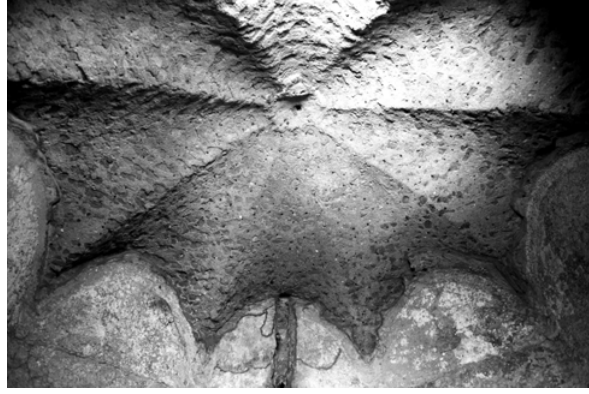
Figure 1. Photograph of the vault.